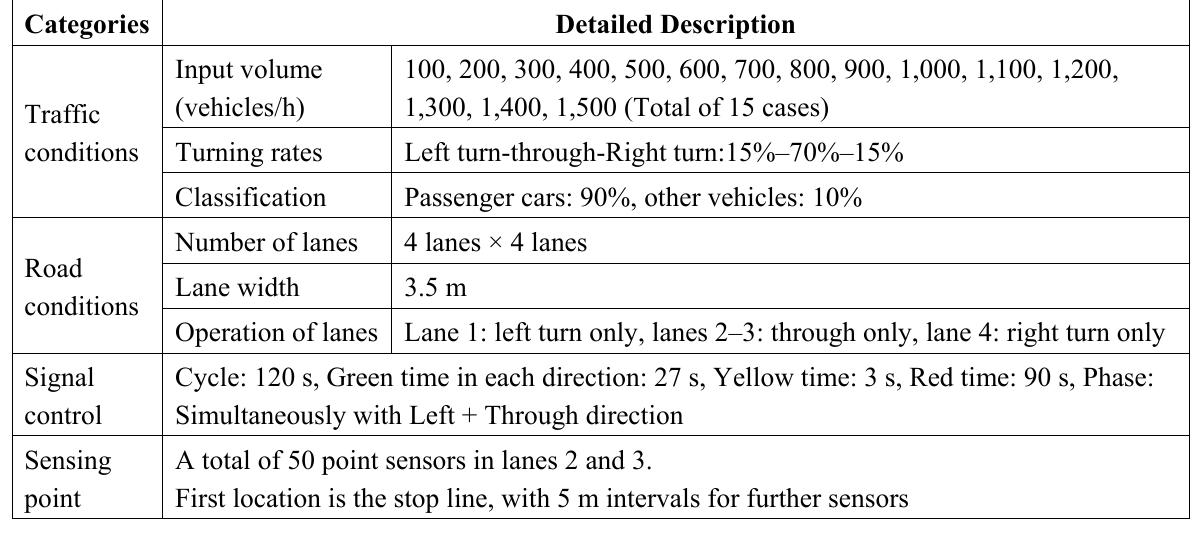
Table 1. Simulation input